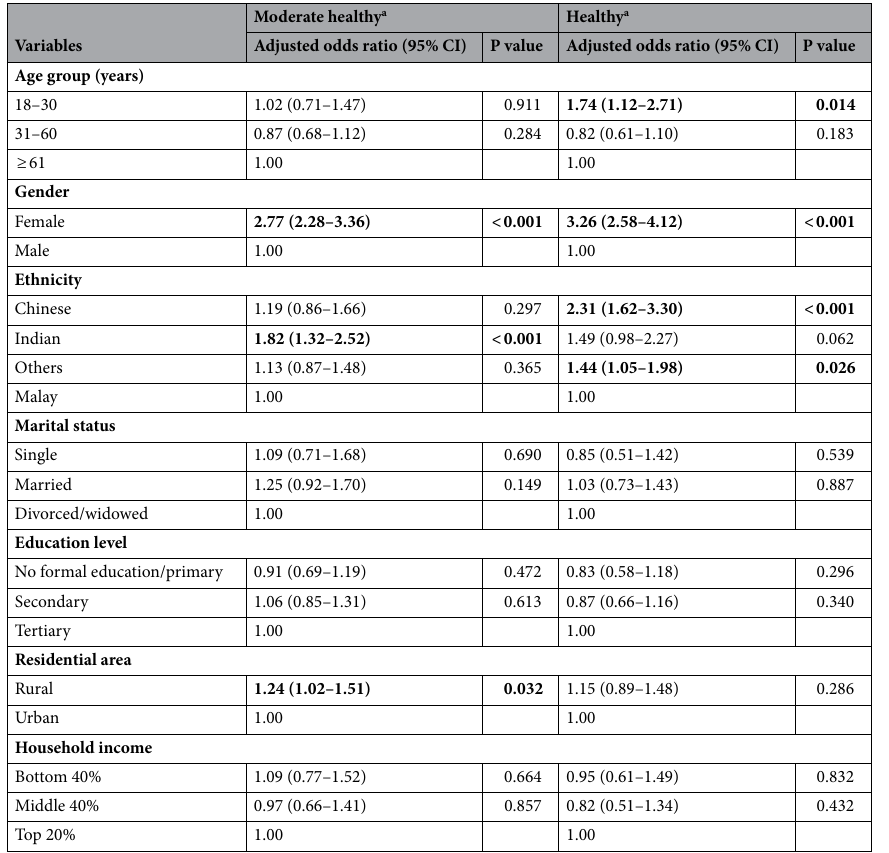
Table 4. Socio-demographic factors associated with healthy lifestyle behaviours categories: multinomial regression analysis. Significant values are in bold. a Reference category =